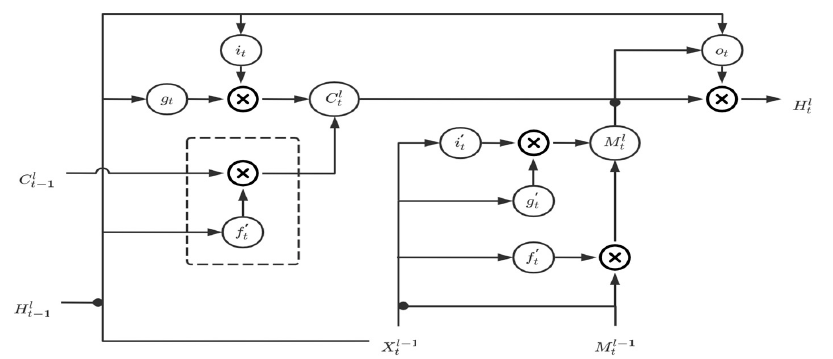
Figure 3. ST-LSTM block.